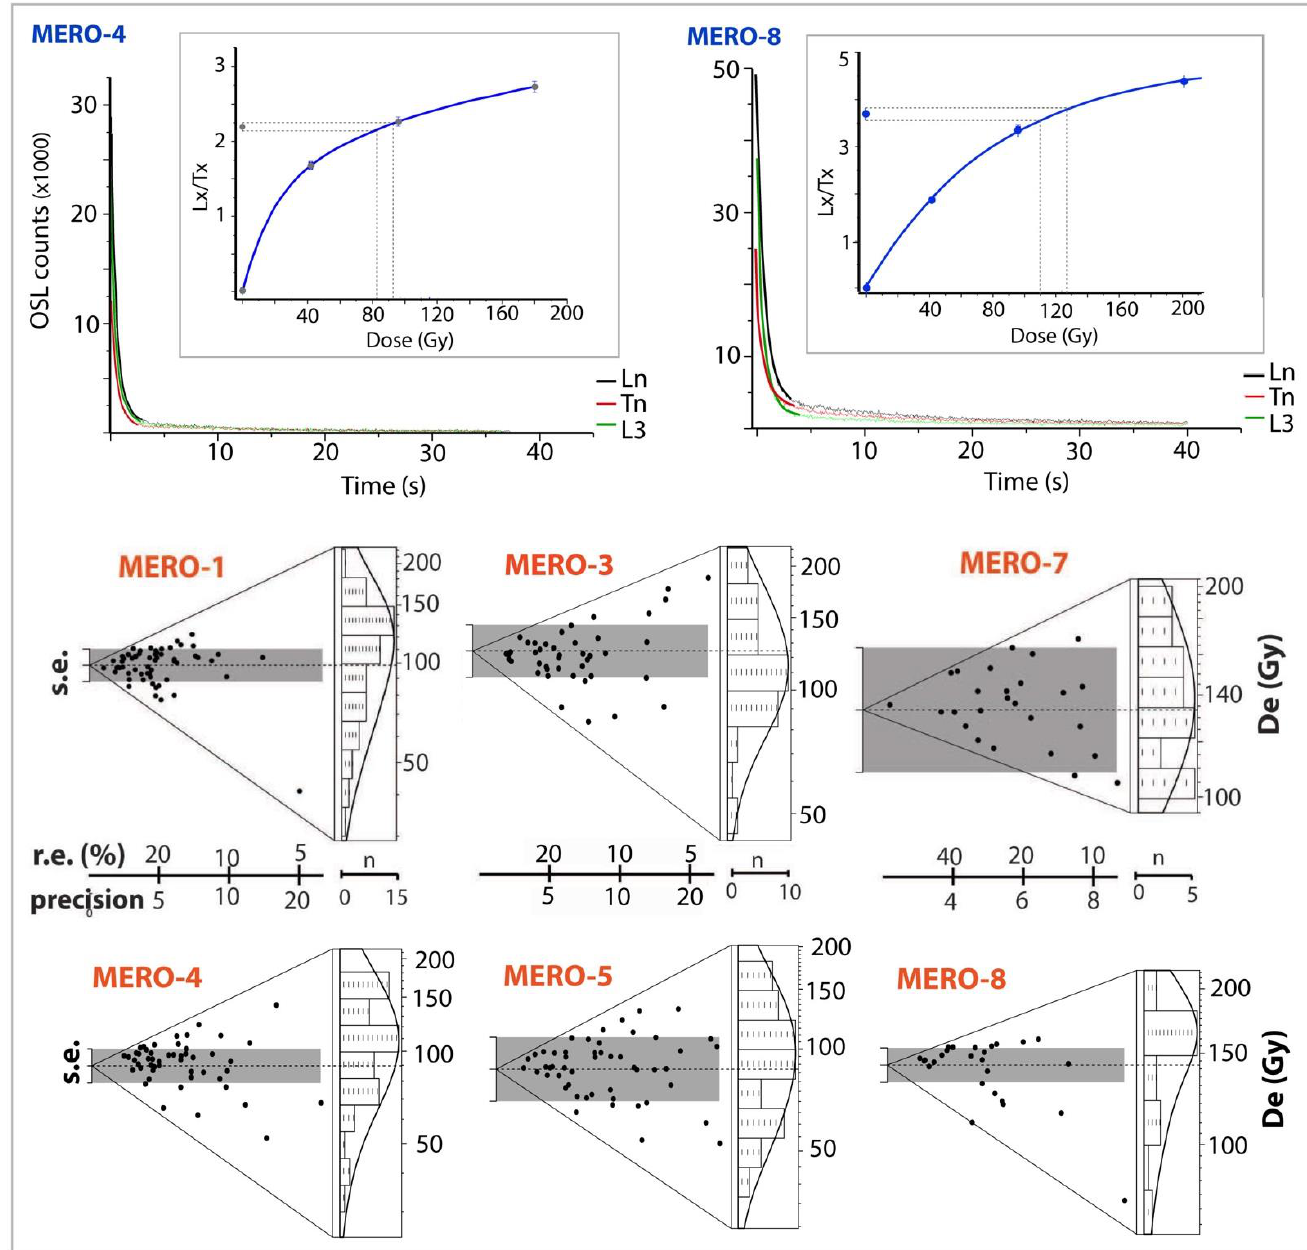
Figure 3. OSL signal and D e s distributions. (Up) Examples of OSL decay curves and growth curves of Mero-4 and Mero-8 samples. (Down) Abanico plots of samples Mero-1, 3, 4, 5, 7 and 8: standard estimate (s.e) and (±2σ) standard error (grey area), relative error (r.e), equivalent dose ( D e ) and accumulate density (n) from each aliquot (black dots).